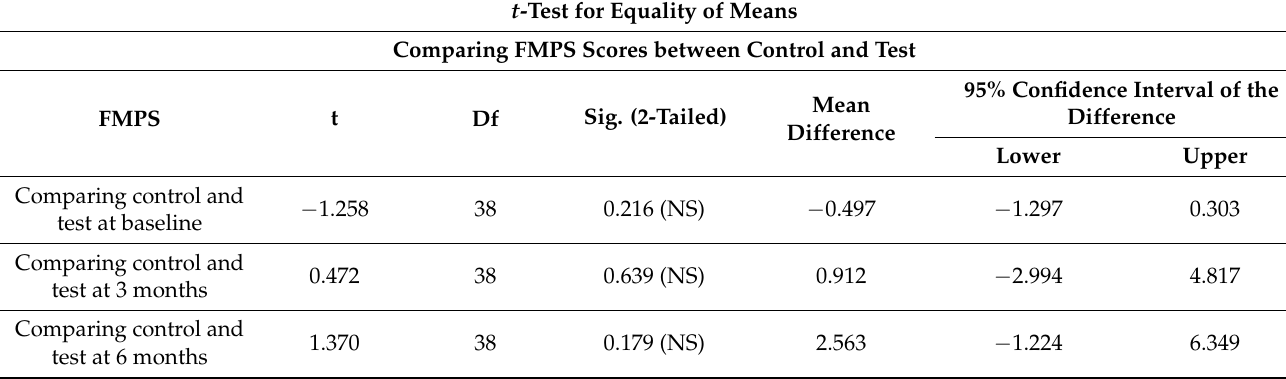
Table 2. Independent t -test for plaque